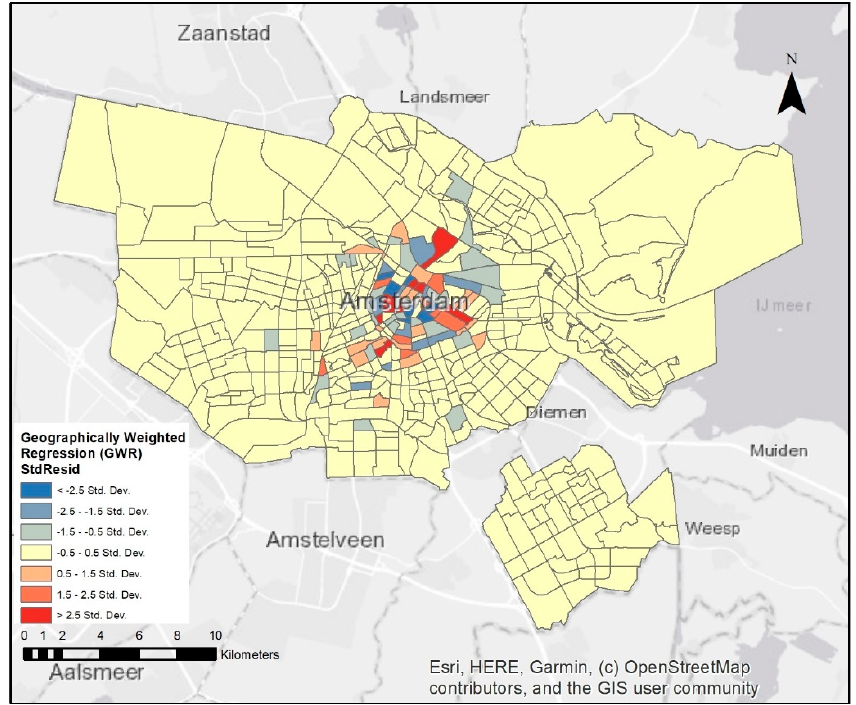
Figure 5. Spatial distribution of geographically weighted regression (GWR) residuals.